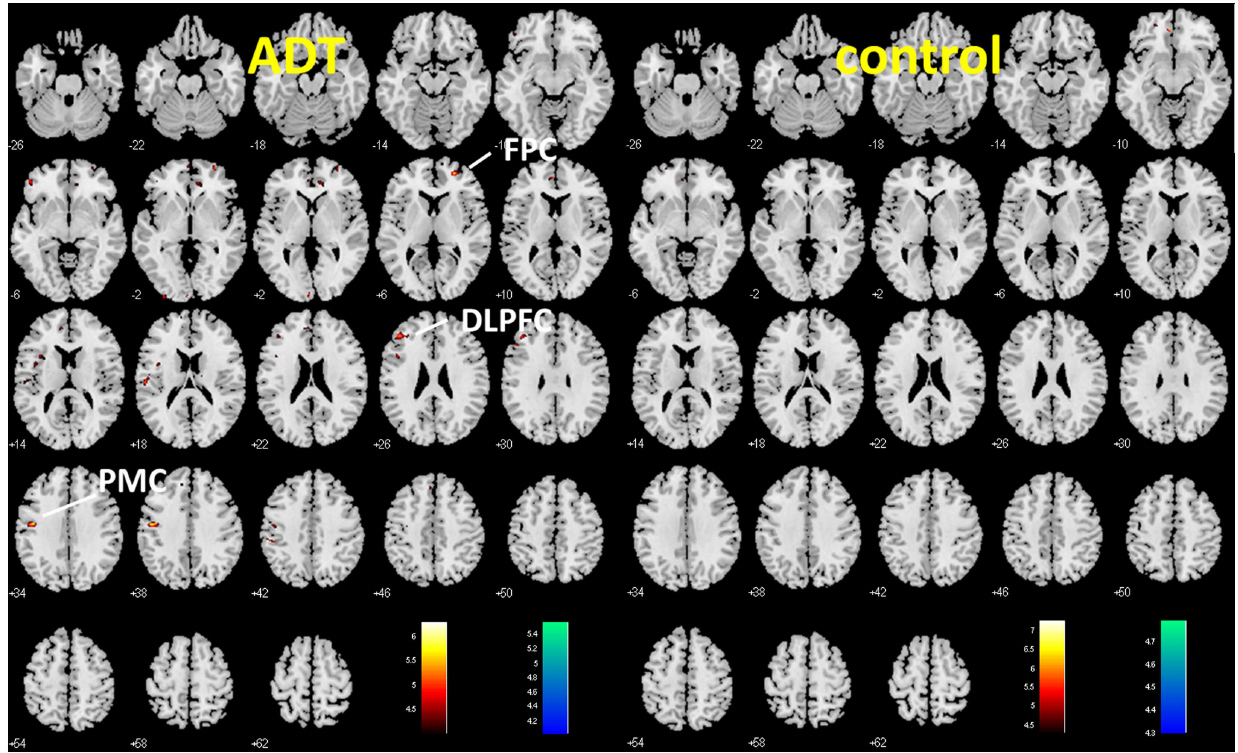
Figure 1. Changes in cerebral gray matter volumes in frontal cortices as demonstrated by voxel-based morphometry. Voxelwise paired t test between baseline and 6 months for ADT (patients who received 6 months of androgen deprivation therapy) and Control (patients who did not receive any hormonal therapy) group, at p , 0.001, uncorrected. The difference in gray matter volume, as reflected by a map of T values (color bar), is shown here on a structural brain image in axial sections, from z=-26 to z= + 62, with adjacent sections 4 mm apart. Warm color: baseline . 6 months; Cool color: 6 months . baseline. Neurological orientation: Right (R)=right. ADT but not control patients showed decreased gray matter volume in the primary motor cortex (PMC), frontopolar cortex (FPC), and dorsolateral prefrontal cortex